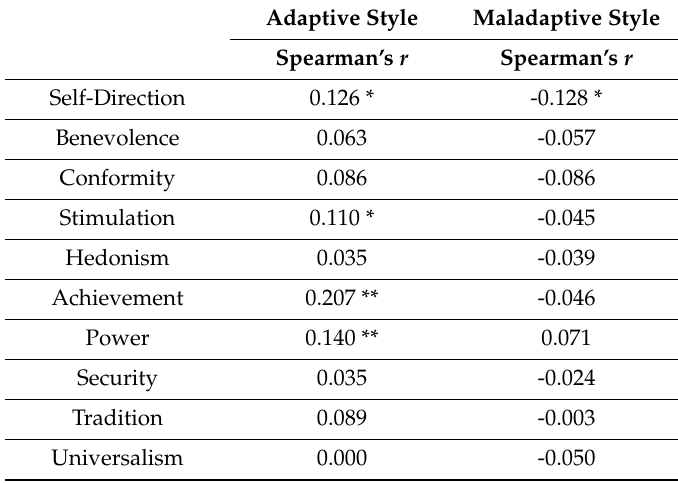
Table 2. Correlation between decision-making styles and value